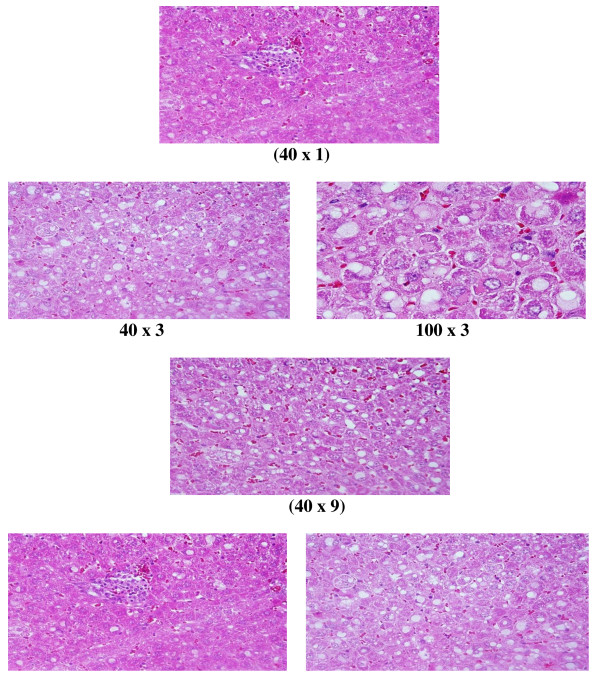
GNPs-treated rat received 100 μl of 10 nm particles for 3 days